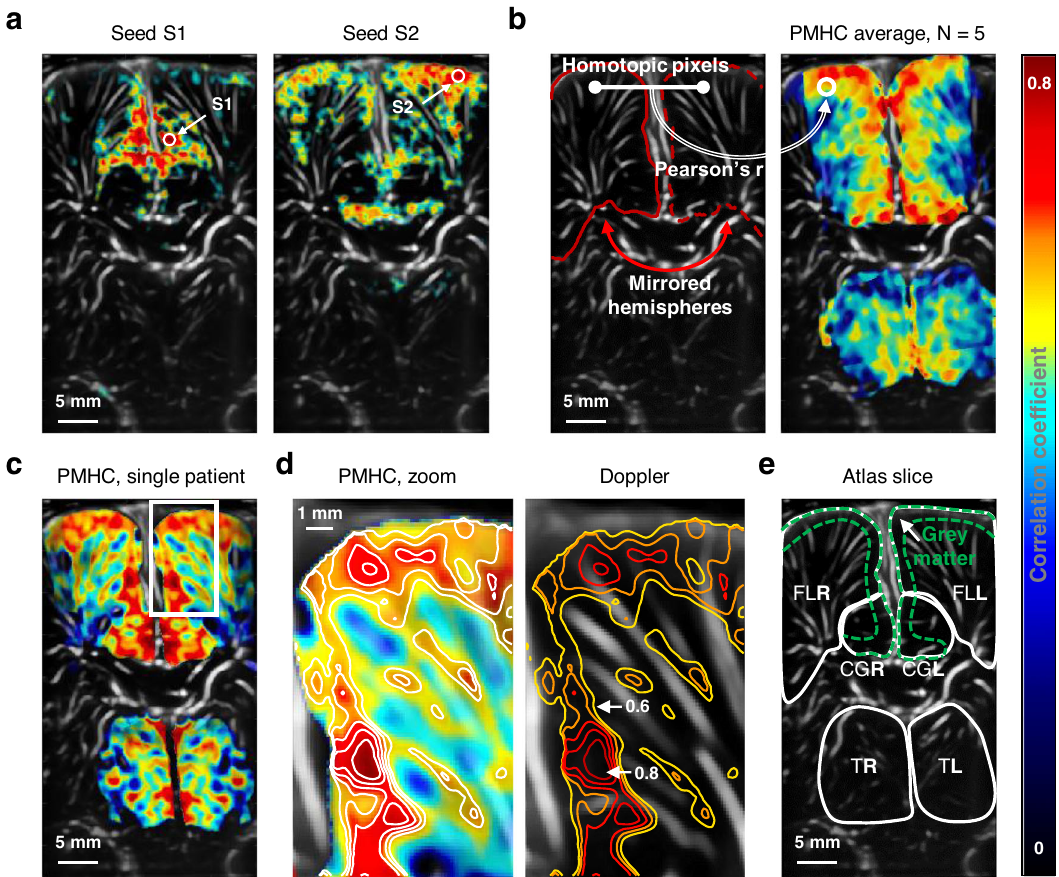
Fig. 3 Seed-based correlation and homotopic connectivity leverage fUS high spatial resolution. ( FL frontal lobe, CG cingulate gyrus, T thalamus, R/L right/left) a Example of seed-based correlations from two seeds S1 and S2 in the left frontal lobe for a single patient. Thresholding on Z score ( p < 0.0001, i.e, z > 3.72). b Pixel-Mirror Homotopic Connectivity (PMHC) map obtained by computing Pearson ’ s correlation coef fi cients for every homotopic pair of pixels. Results are averaged for N = 6 very preterm neonates. c Example of a PMHC map for a single patient. A layered structure is visible in frontal lobe FL and CG. d Zoom on c white box. Several iso-lines are traced for r values ranging from 0.6 to 0.8, with a 0.05 step. Left panel shows the PMHC and right panel shows the corresponding vascular Doppler map. e Corresponding Markopoulos atlas slice showing gray matter segmentation in FL and